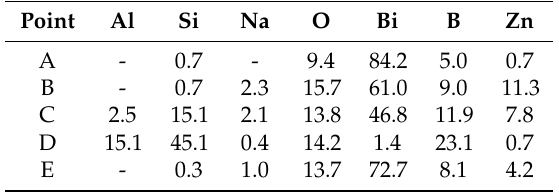
Table 3. Point scan analysis of the points marked in Figure 9b,d (in wt.%). Point Al